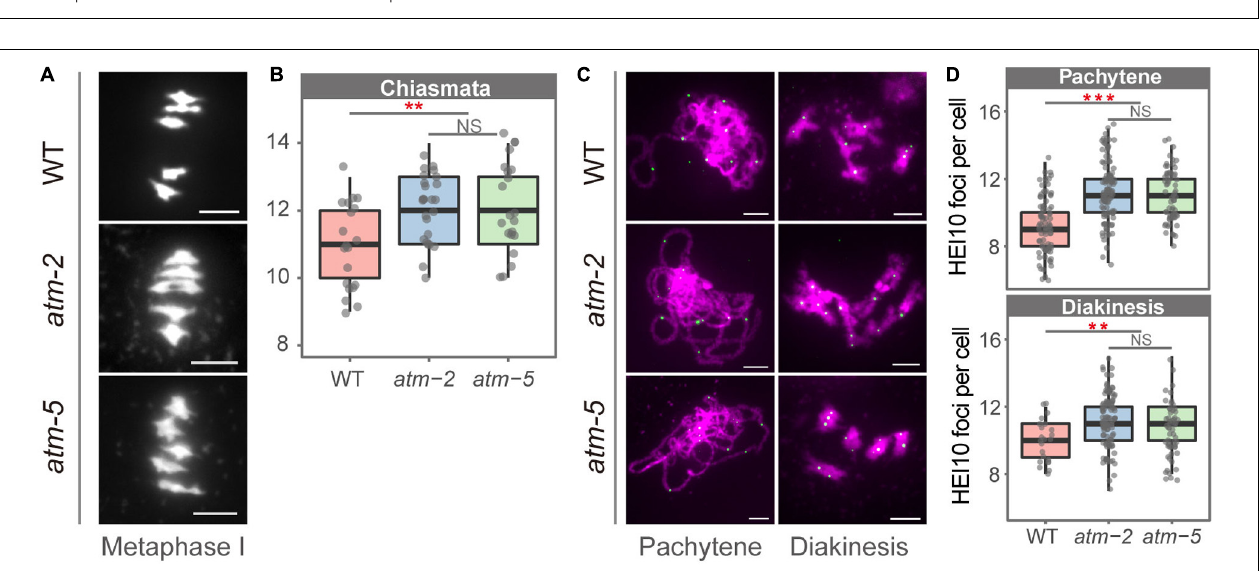
29% of atm-5 meiocytes have two early separated homologous chromosomes ( Figures 6C2 , 7A and Supplementary Table S7